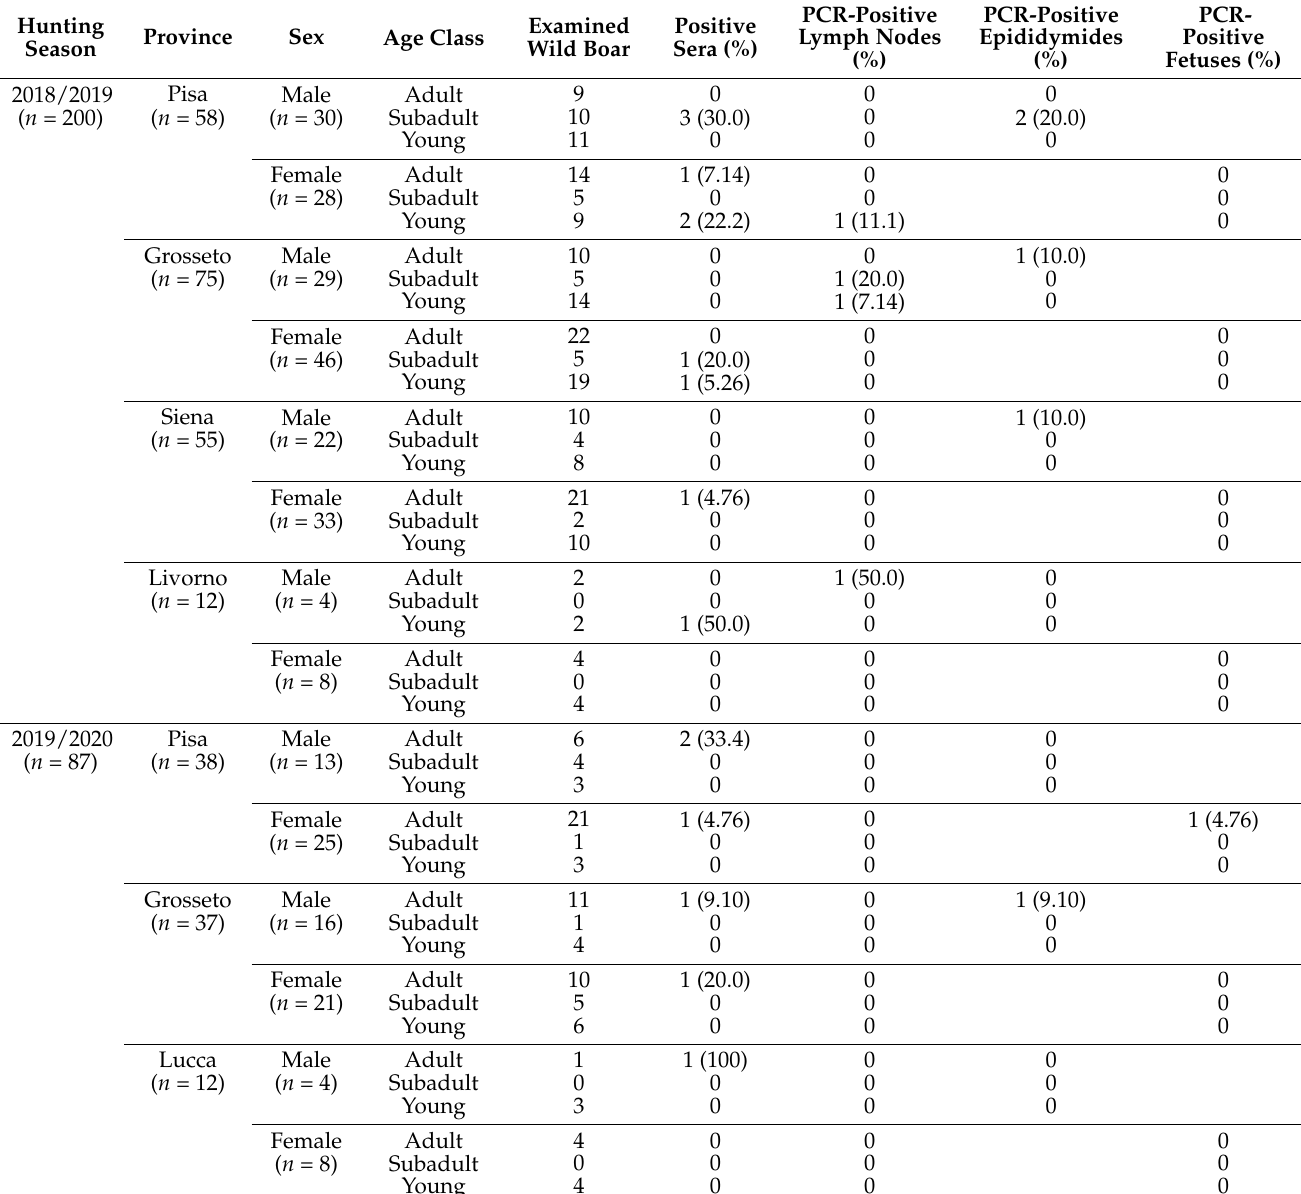
Table 1. Distribution of positive sera and organs for pathogenic Brucella spp. in relation to hunting season, province, sex, and age